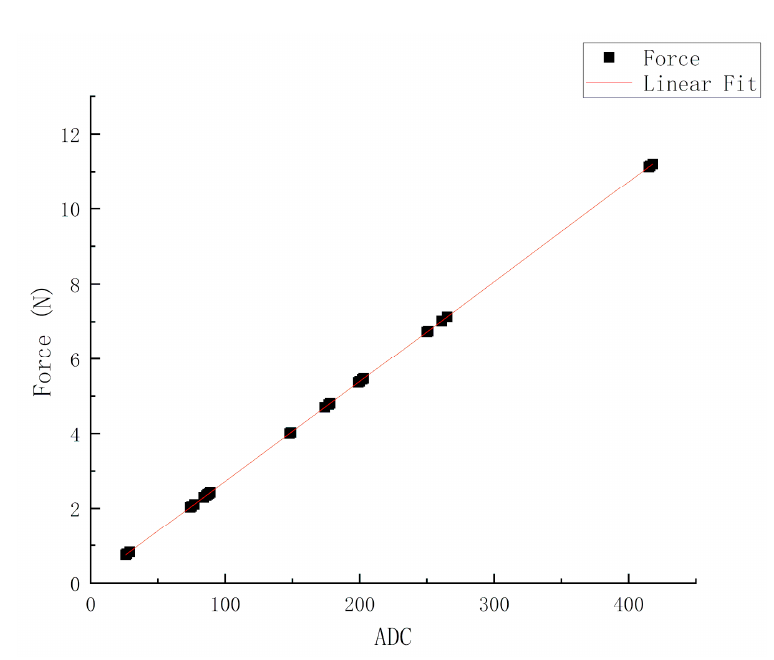
Figure 7. The calibration and fitting of the force curve of the pressure sensor.